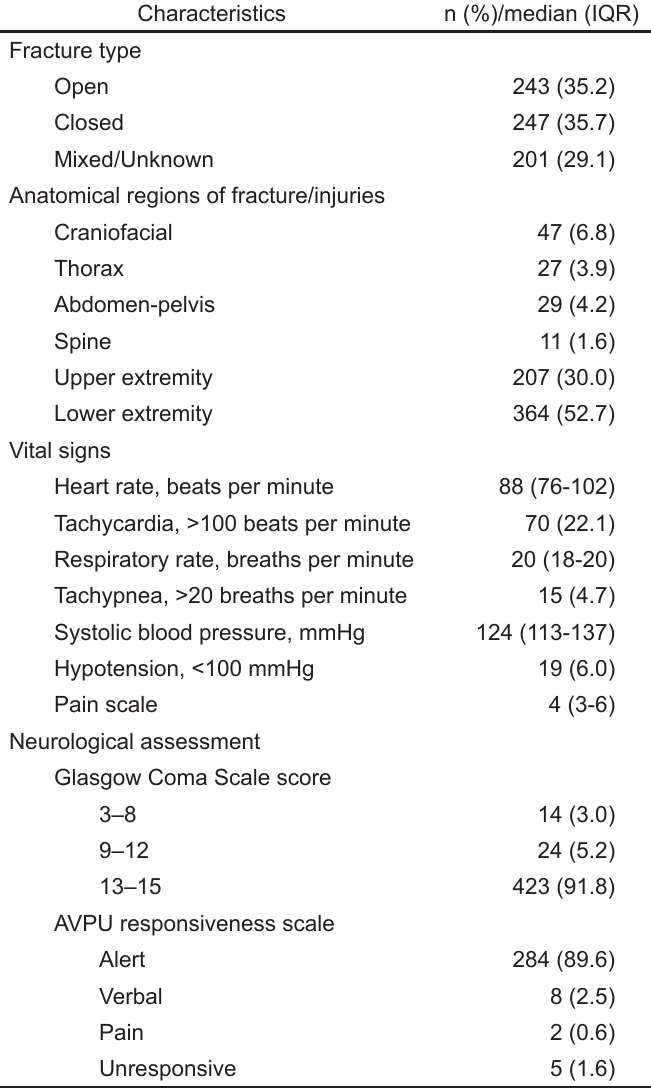
Table 1. Clinical characteristics of musculoskeletal